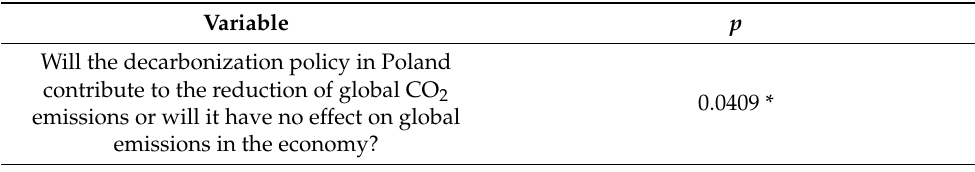
Table 3. Results of determining the relationship of individual responses with respect to the assessment of willingness to use PV